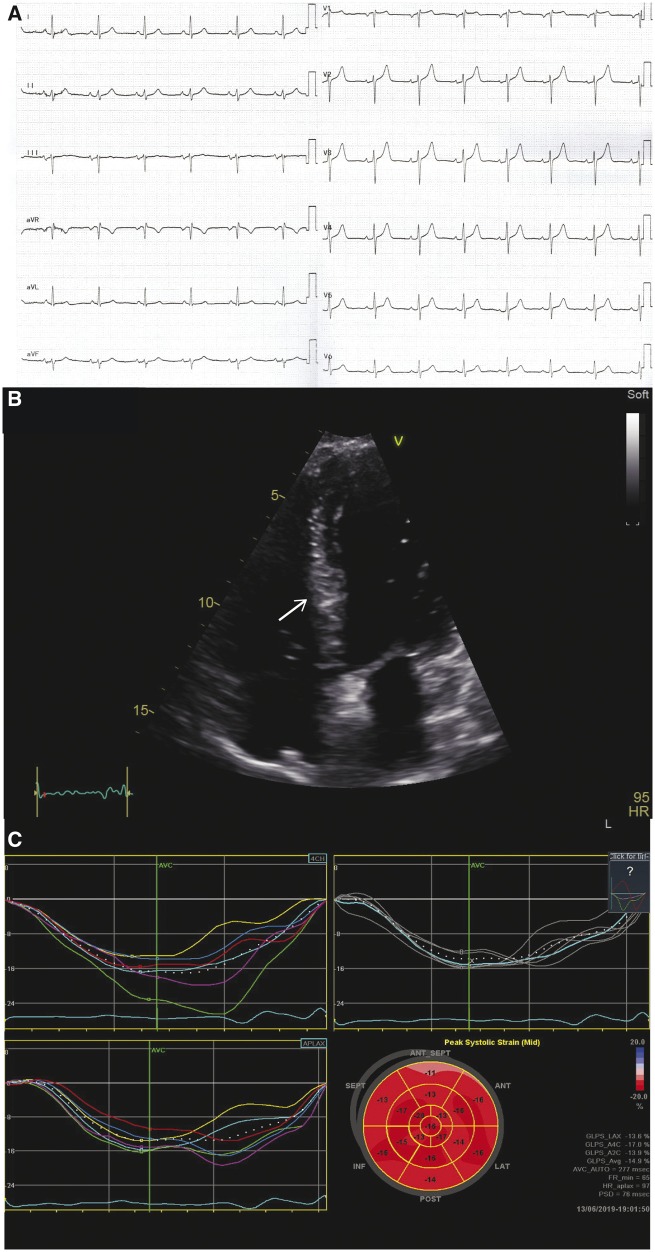
(A) Electrocardiogram obtained 12 weeks after treatment initiation with normalization of T waves in inferior leads (II, III, and aVF). (B) Echocardiogram obtained 12 weeks after treatment initiation showing persistent reduction in cardiac metastatic size (arrows) with improvement in global longitudinal strain and normalization of contraction pattern (C).